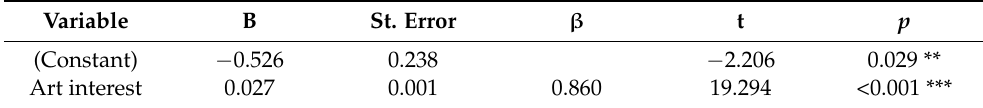
Table 5. Regression analysis summary for aesthetic judgment.